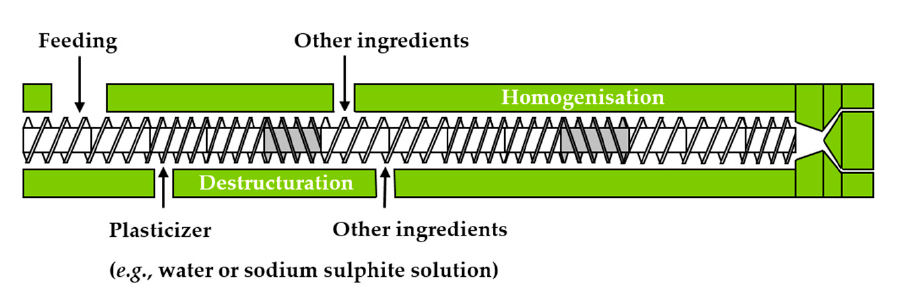
Figure 1. Twin-screw extrusion